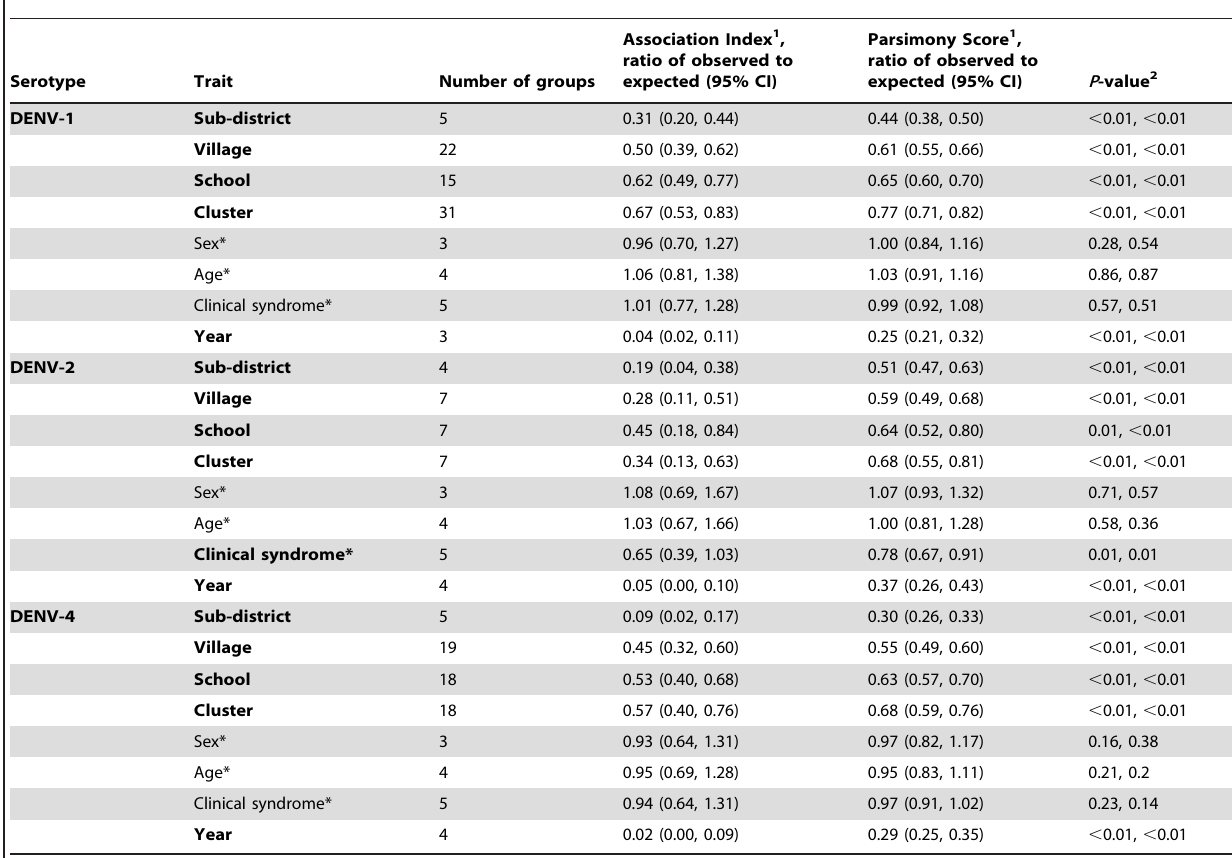
Traits showing significant phylogenetic structure are indicated in bold. *Analysis included separate groups for mosquito isolates or unknown traits where applicable. 1 AI and PS scores are based on mean values representing the association between trait and phylogeny. 2 P -values are based on median values representing the association between trait and